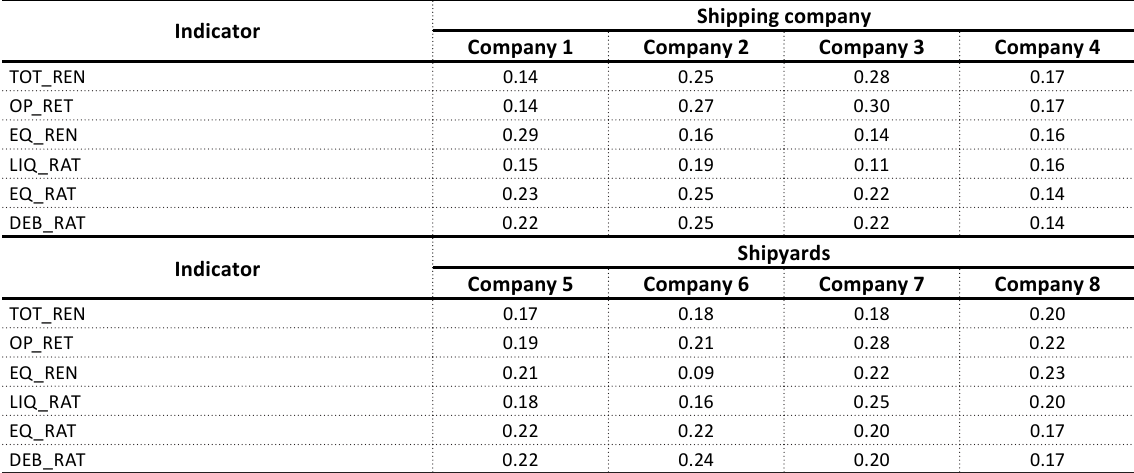
Table 4. Partial functions determined according to the Harrington’s